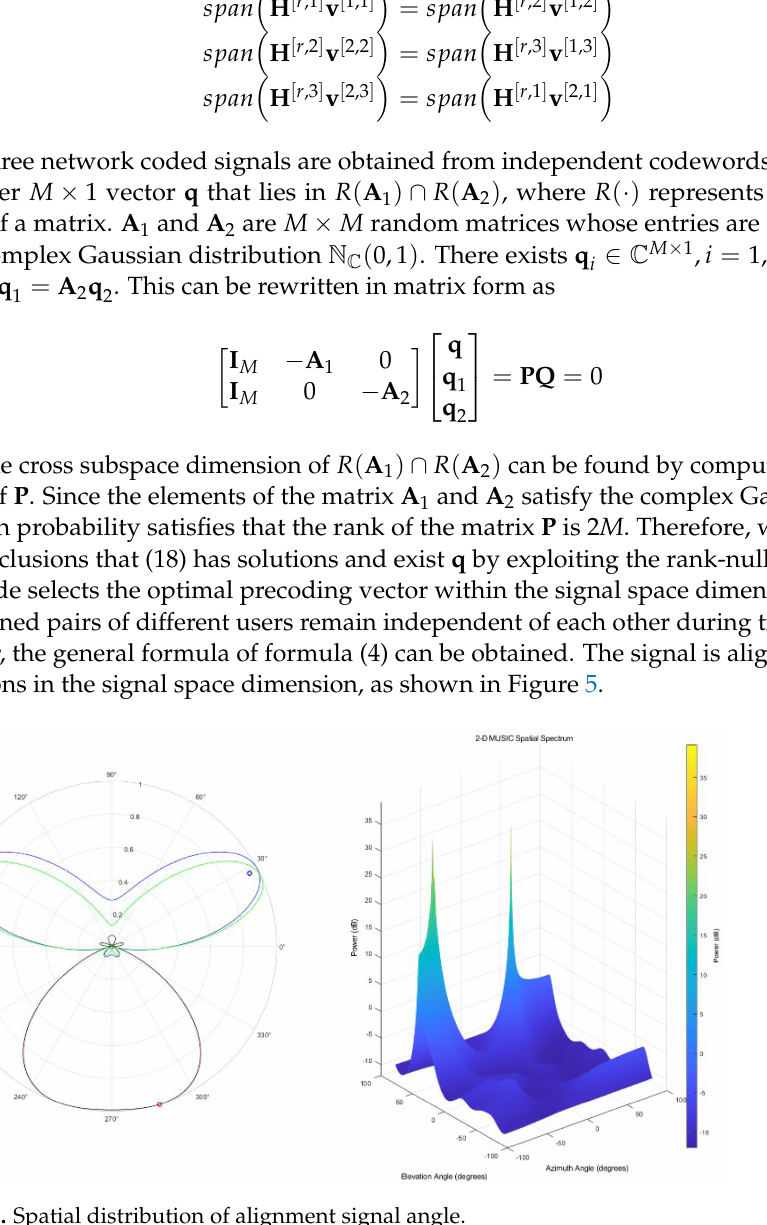
Figure 5. Spatial distribution of alignment signal